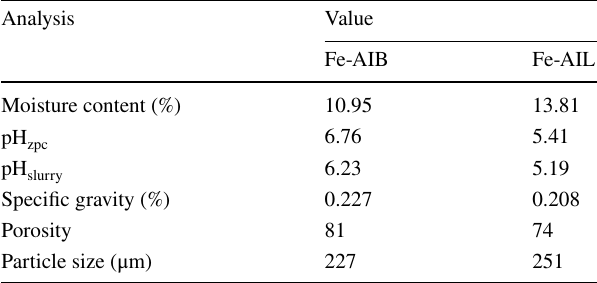
Table 2 Physio-chemical properties of Fe-AIR